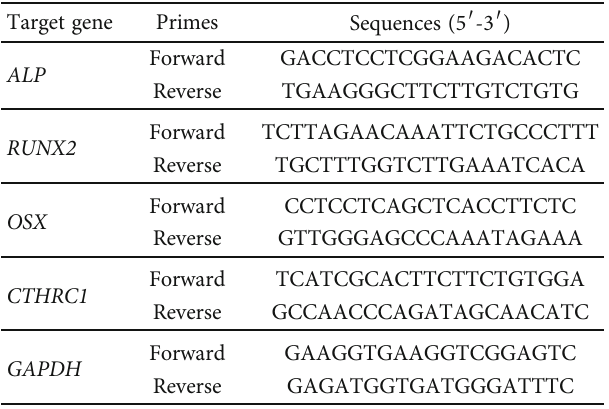
Table 1: The sequences of primer for qRT-PCR analysis. Target gene Primes Sequences (5 ′ -3 ′